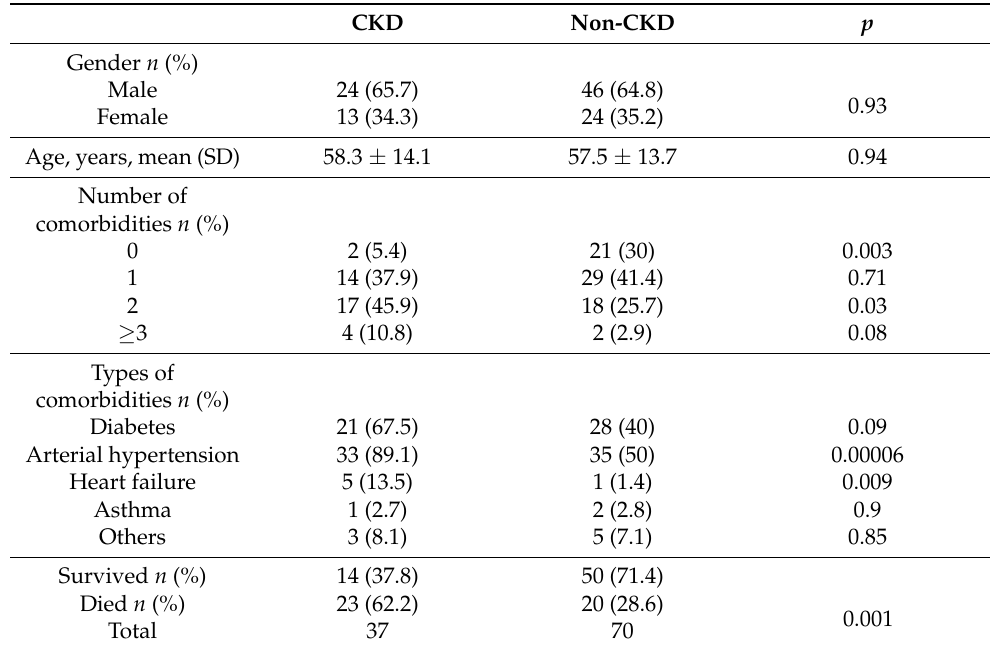
Table 1. Main demographic characteristics of study